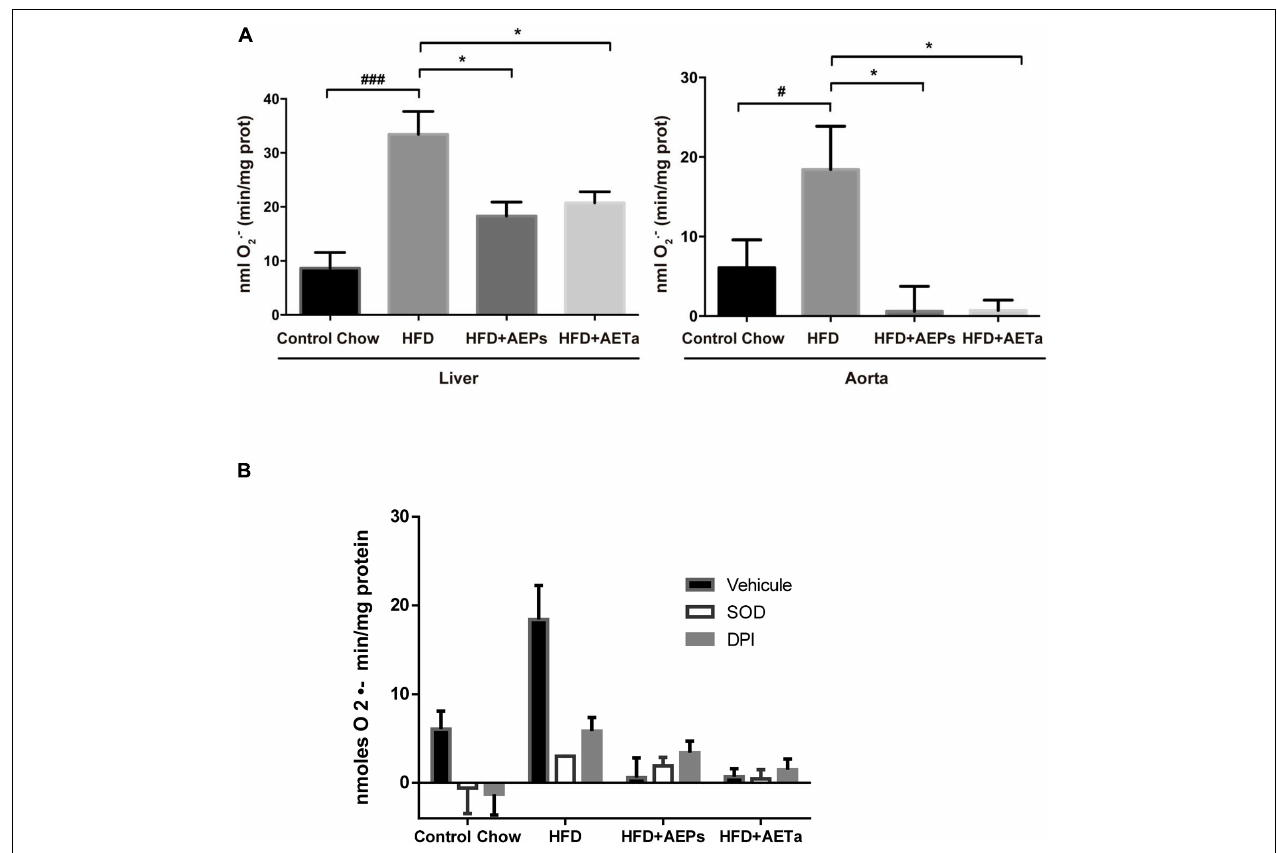
FIGURE 6 | Effect of Prosopis strombulifera or Tessaria absinthioides on NOX-derived superoxide. (A) NOX-derived superoxide was measured by cytochrome c reduction assay in homogenates of liver and aortas from ApoE-KO mice fed a control diet or high-fat diet (HFD) alone or treated with AEPs or AETa (150 or 300 mg/kg/day, respectively) in the drinking water in the last 4 weeks. Data are means ± SEM ( n = 4–6 mice per group). # p ≤ 0.05 and ### p ≤ 0.001 vs. control chow; * p ≤ 0.05 vs. HFD. (B) Validation of superoxide dismutase (SOD)- and diphenylene iodonium chloride (DPI)-inhibitable superoxide production. As any electron donors can also reduce cytochrome c , the assay must therefore also be performed in the presence of SOD, which removes superoxide. Only the SOD-inhibitable signal truly reflects superoxide production. Here, we present the nmoles O 2 − min/mg protein generated by aorta tissue in the presence of SOD or DPI, a general flavoprotein inhibitor. AEPs, aqueous extract of P. strombulifera ; AETa, aqueous extract of T. absinthioides ; NOX, NADPH oxidase; ApoE-KO, apolipoprotein E-knockout; SOD, superoxide dismutase; DPI, diphenylene iodonium chloride.